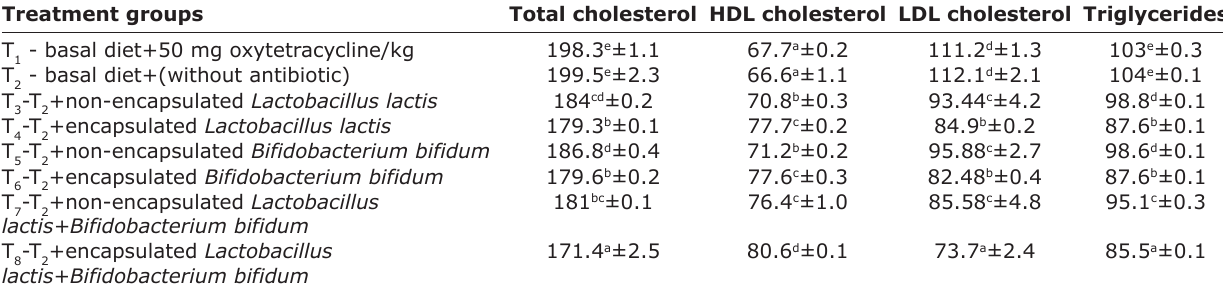
Table-2: Mean (± SE) lipid-protein profile (mg/dl) of broiler chicken supplemented with non-encapsulated and encapsulated probiotic bacteria. Treatment